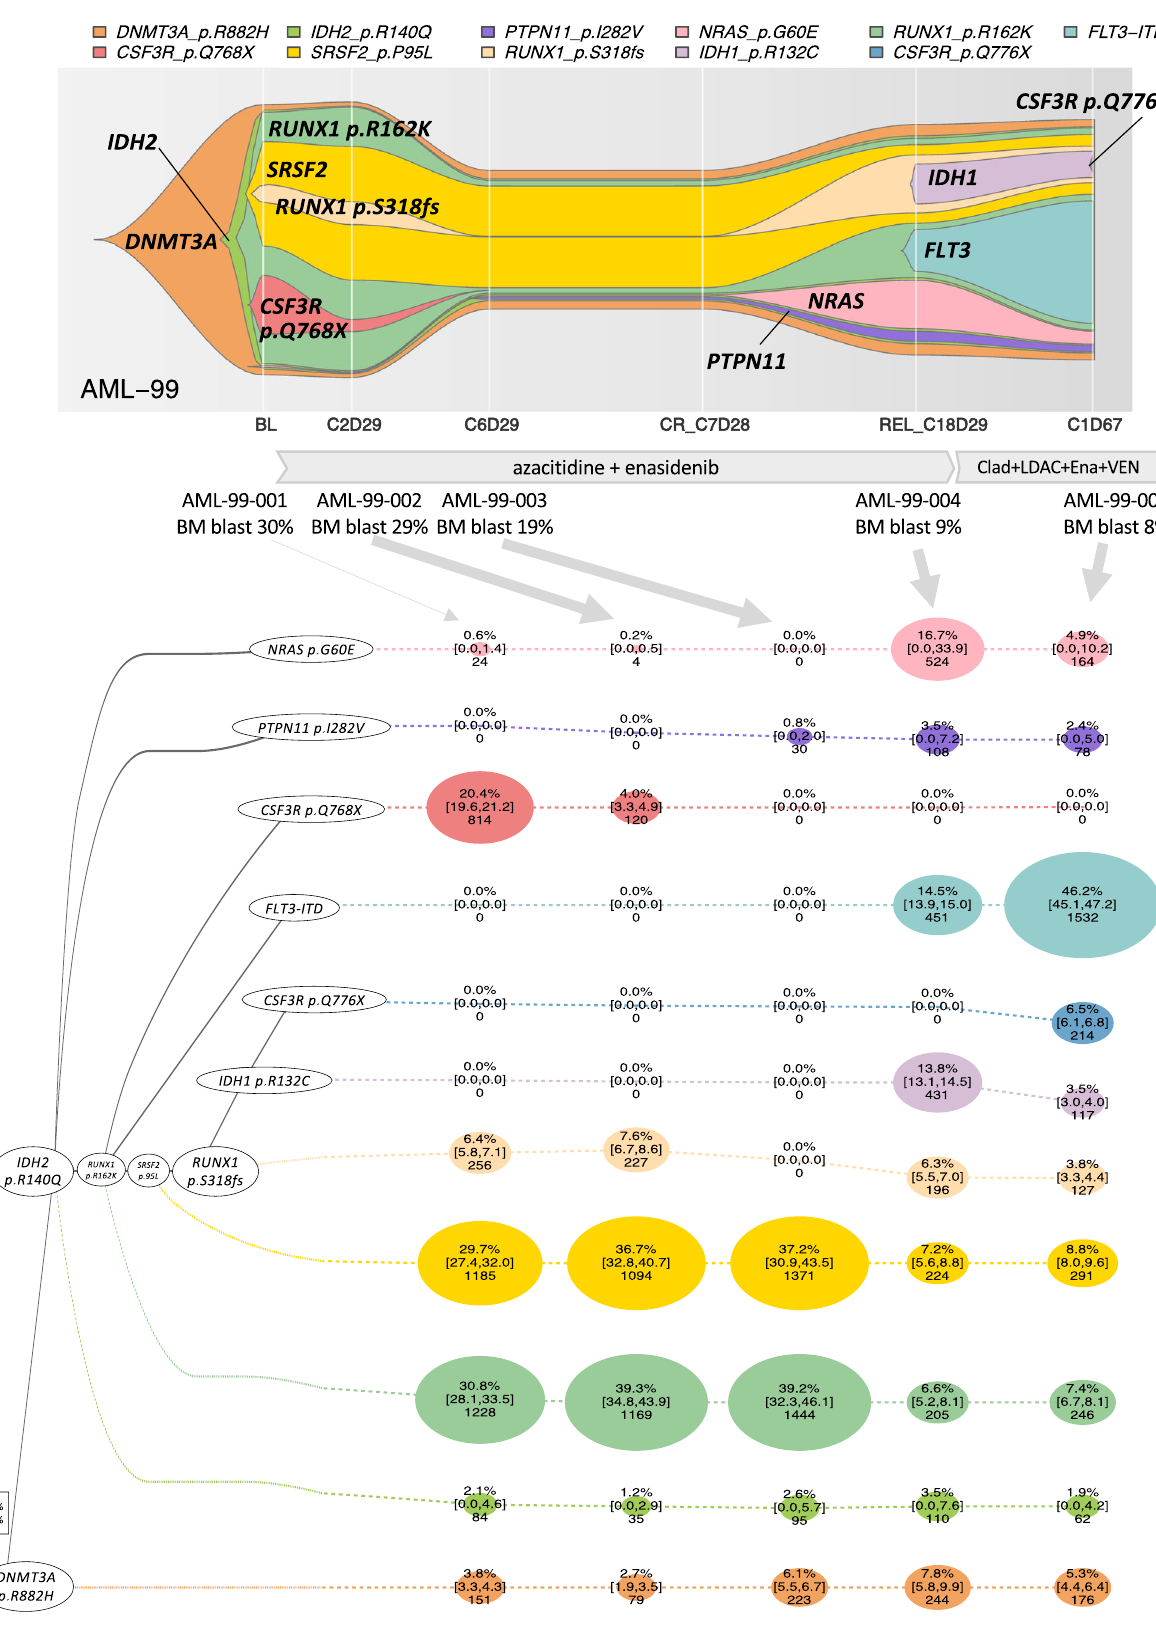
Fig. 7 Emergence of IDH1/FLT3/NRAS clones during IDH2 inhibitor-containing therapy. A 76-year old woman with AML showing the parallel evolution of IDH1 p.R132C, FLT3 -ITD, NRAS p.G60E, and PTPN11 p.I282V clones during an IDH2 inhibitor-containing therapy. Clad cladribine, LDAC low dose cytarabine, Ena enasidenib, VEN venetoclax, DAC decitabine. The fi sh plot shows the inferred clonal evolution pattern based on the single-cell genotype data. The phylogenetic trees visualize the estimated order of mutation acquisition and the proportion of subclones with a different combination of mutations at each timepoint. The wild-type cells which did not carry any driver mutations are not shown. BL baseline, CR complete remission, C cycle, D day, REL relapse, ADO allele dropout, FPR false-positive rate. Full case description is available in Supplementary